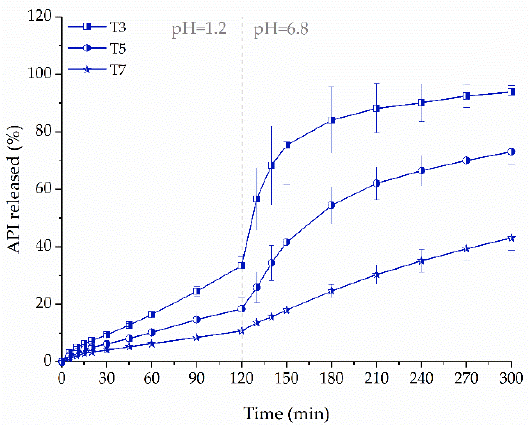
Figure 11. The influence of dosage on dissolution profiles of ketoprofen from 3DP tablets made from F3 filament (infill density equal to 35%).